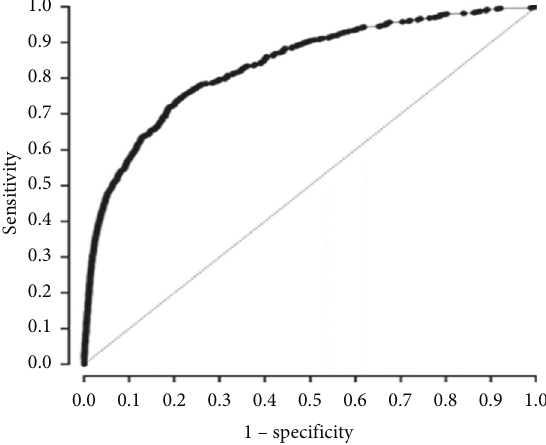
Figure 1: Multivariate logistic regression ROC